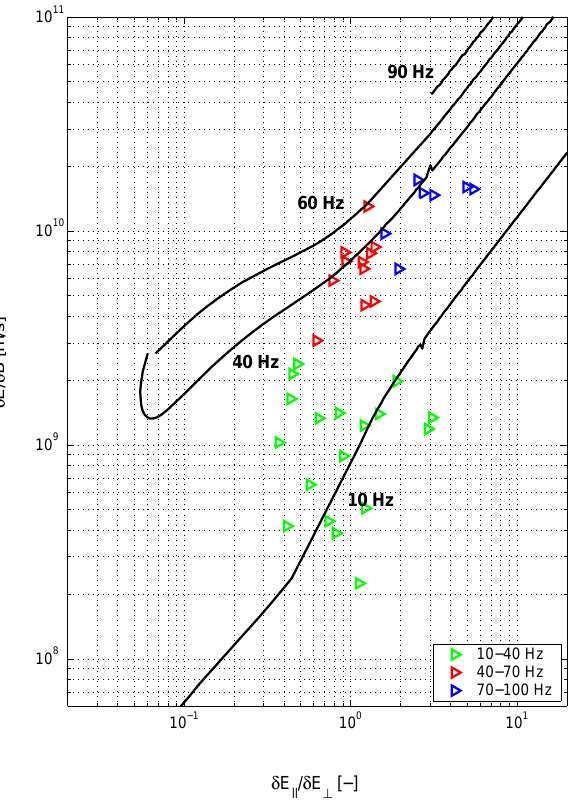
Fig. 11. A short burst of waves is analyzed using the same technique leading to Fig. 3. The data points (triangles) are divided into three frequency intervals. On top of the data points we present constant frequency curves obtained using the dispersion solver WHAMP.